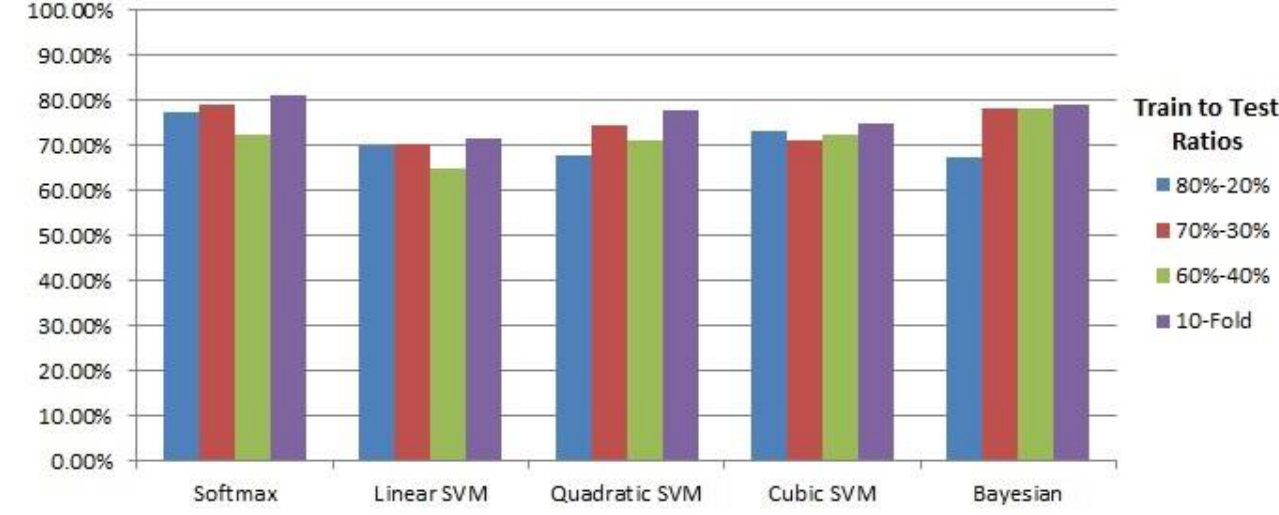
Figure 5. Accuracy results for various train-to-test ratios using original dataset.